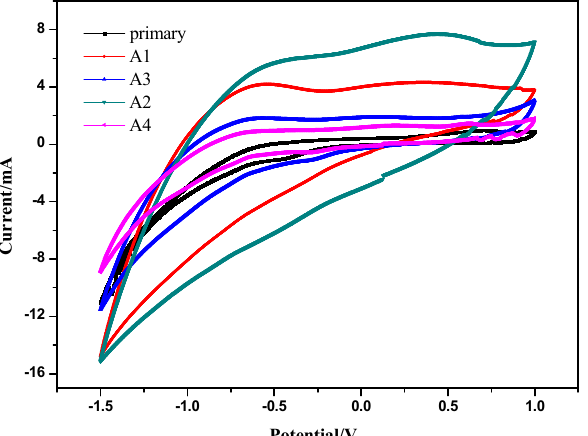
Figure 4. CV curves of anodic carbon felt of MFCs (A1: 0.1 g zero-valent iron; A2: 0.5 g zero-valent iron; A3: 1 g zero-valent iron; A4: no zero-valent iron).